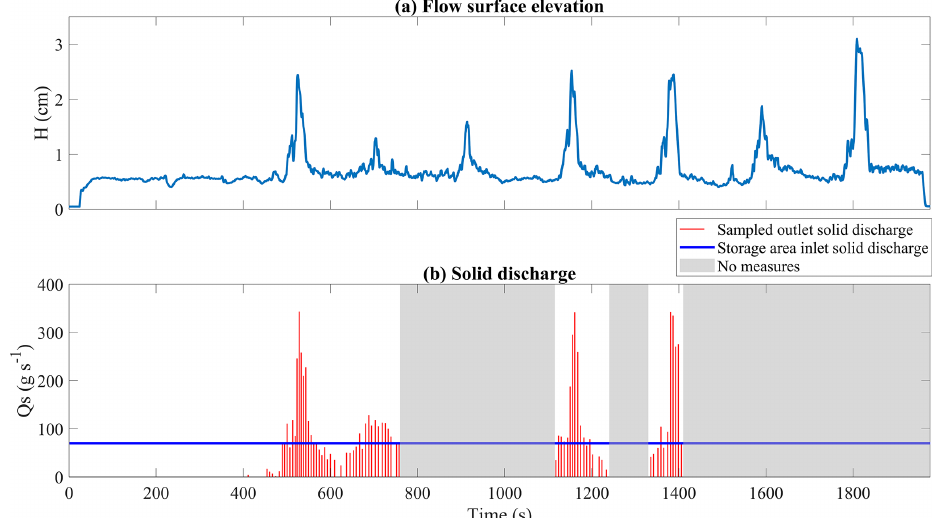
Figure 6. In-channel measurement time series of flow surface elevation and solid discharge. Panel (a) shows flow surface elevation as measured in the middle section. Panel (b) shows outlet solid discharge (red bars) compared with inlet solid discharge (blue horizontal line). It is worth recalling that these measurements refer to a different experiment from that presented in Sect. 3.1.